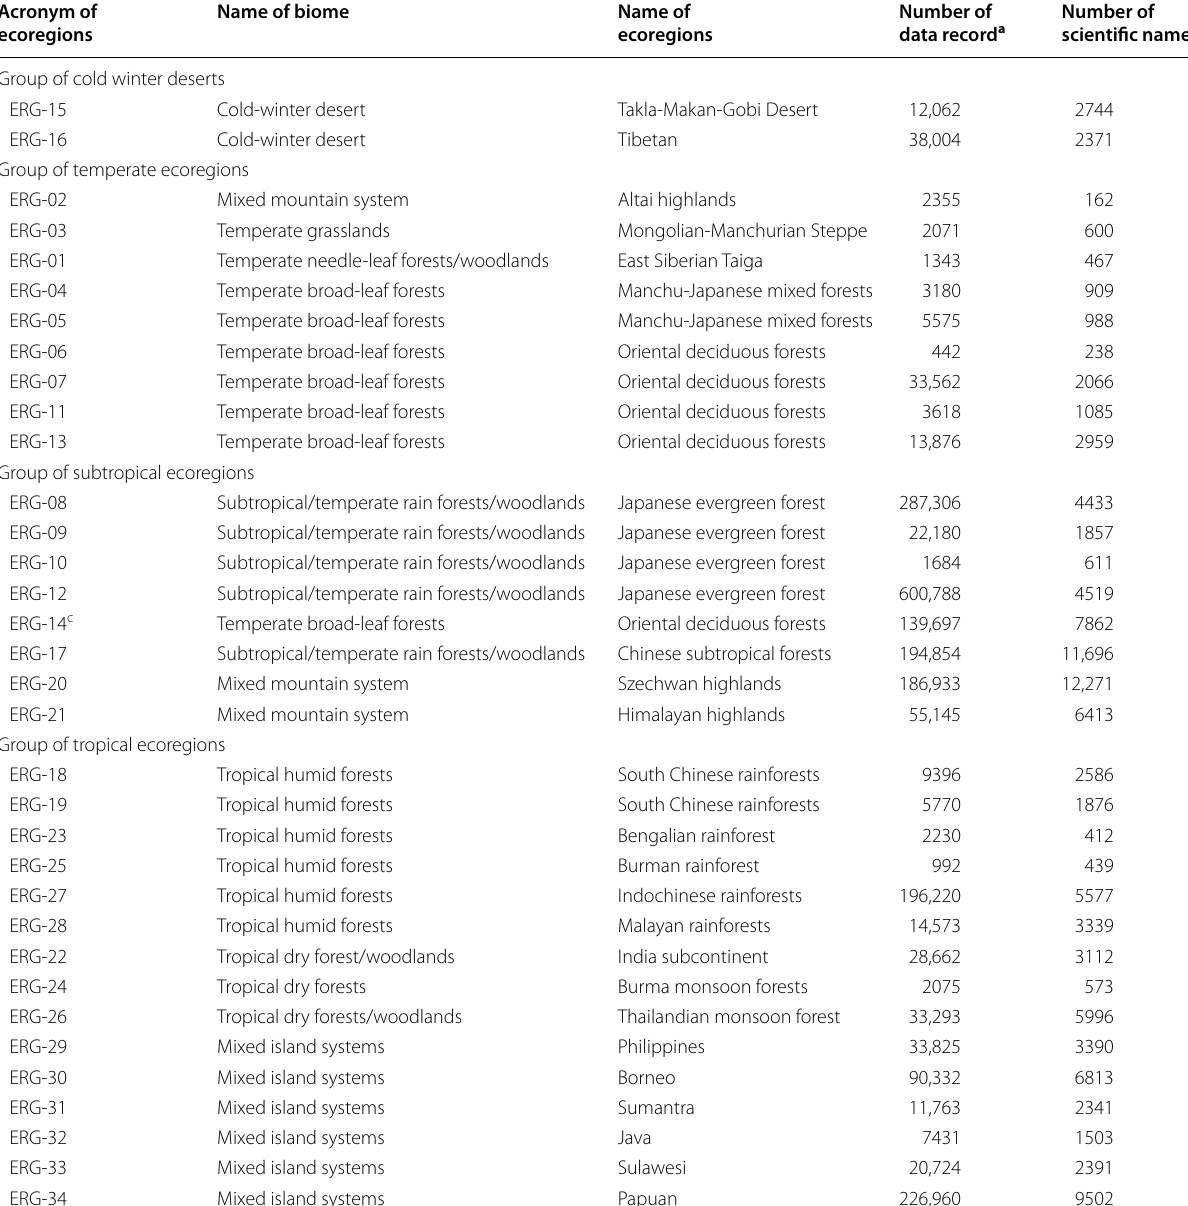
Table 1 The names and abbreviations of biomes and 34 terrestrial ecoregions in Asia Acronym of